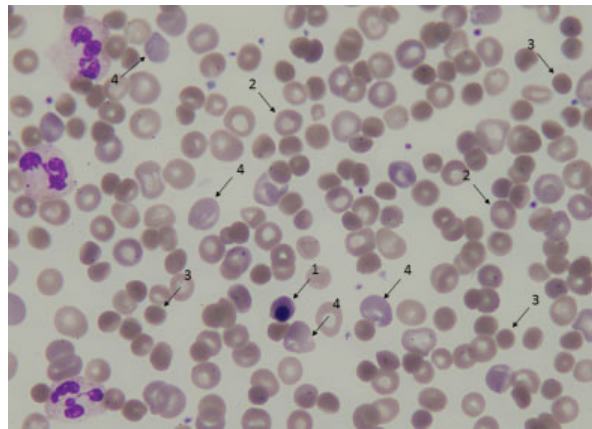
Fig. 1 Peripheral blood smear of the patient. Orthochromatic erythroblast (1), normal erythrocytes (2), microspherocytes (3), and polychromatic erythrocytes